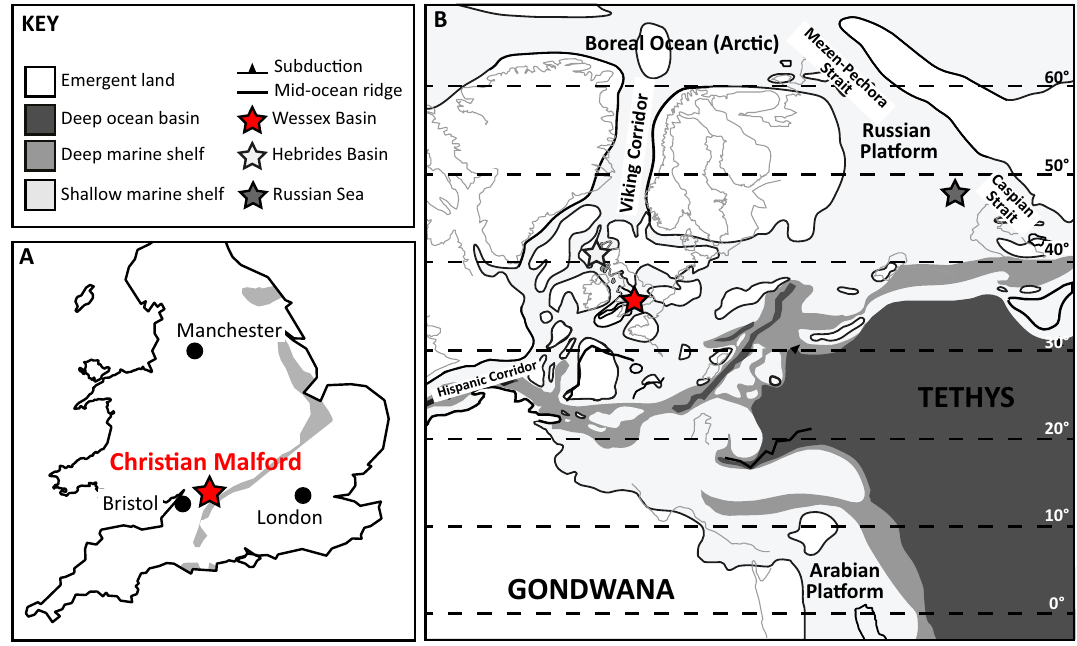
Figure 1. ( A ) Sampling location (Christian Malford) in the U.K., denoted by star, with the outcrop of Callovian sediments indicated by grey band, after Price et al. 42 . ( B ) Palaeogeographic reconstruction of the Tethyan Realm during the Middle Jurassic, after Dera et al. 63